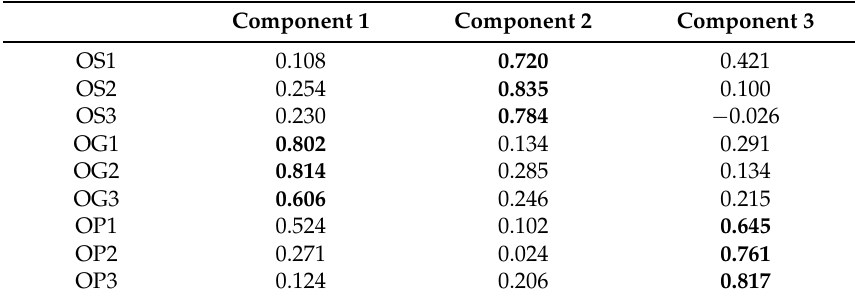
Table 7. Rotated component matrix of